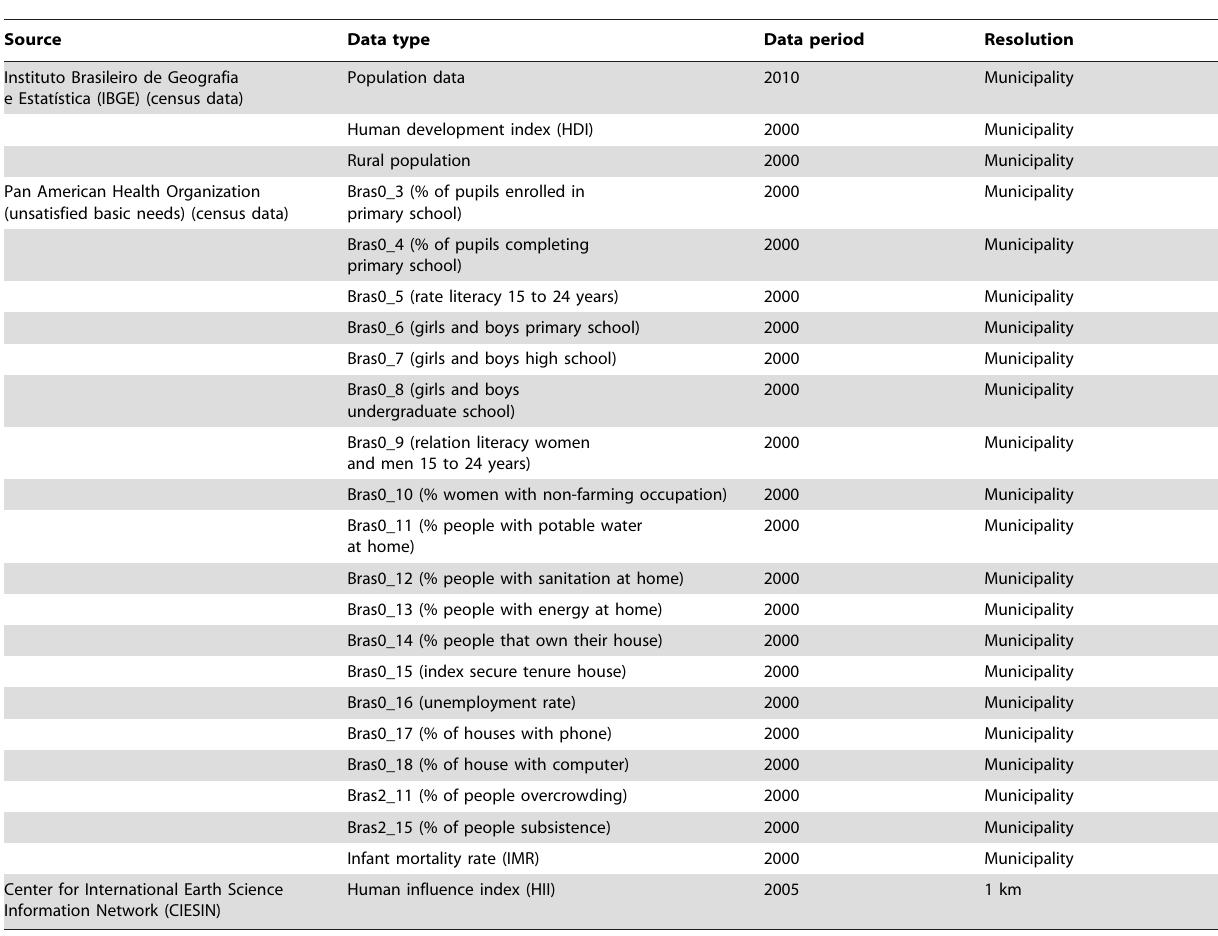
Table 2. Socioeconomic predictors used for geostatistical modeling of leishmaniasis in Brazil for 2001–2010.